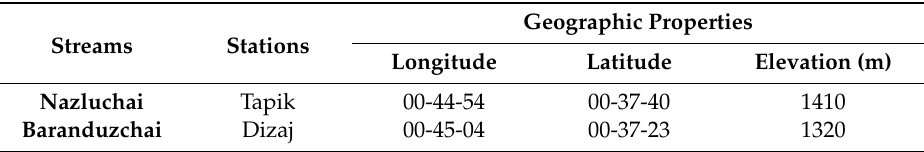
Table 1. The geographical properties of monthly streamflow of both streams.